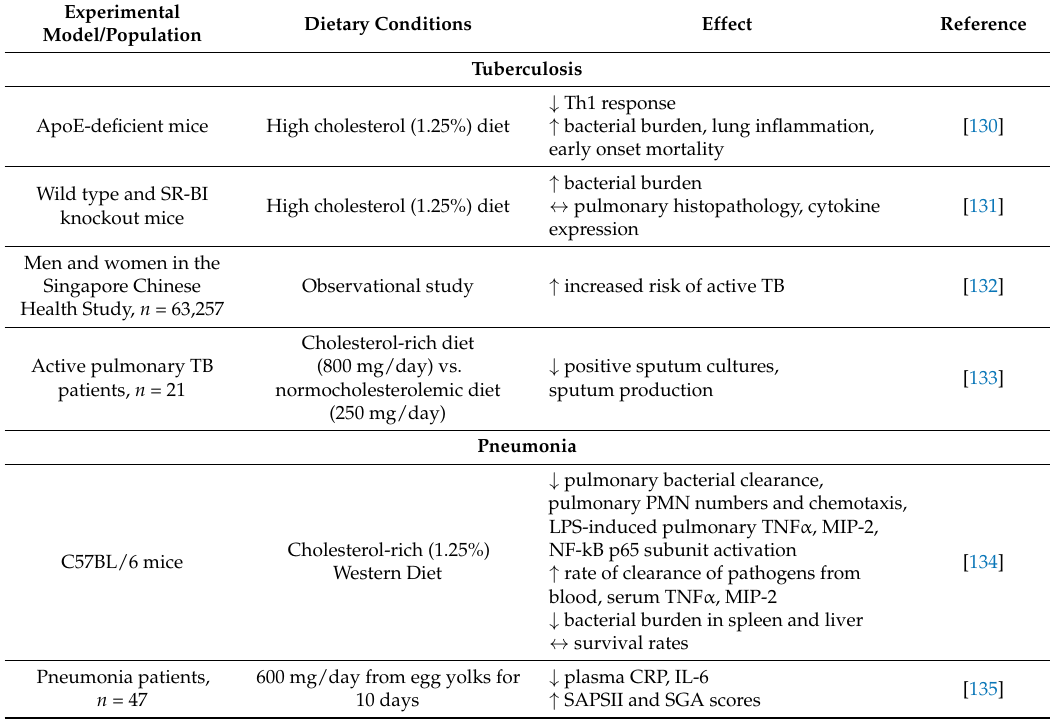
Table 1. Comparative effects of dietary cholesterol on infection by bacterial pathogens.